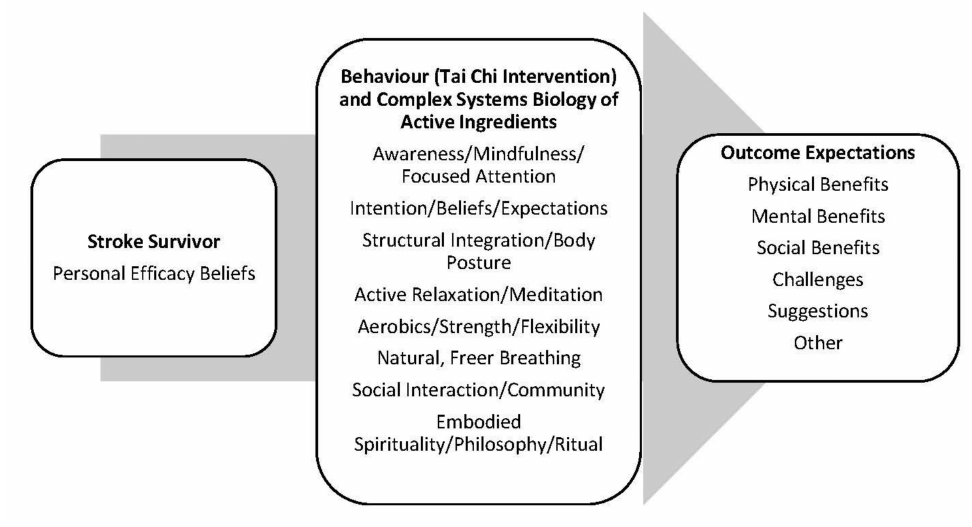
Figure 1. Theoretical